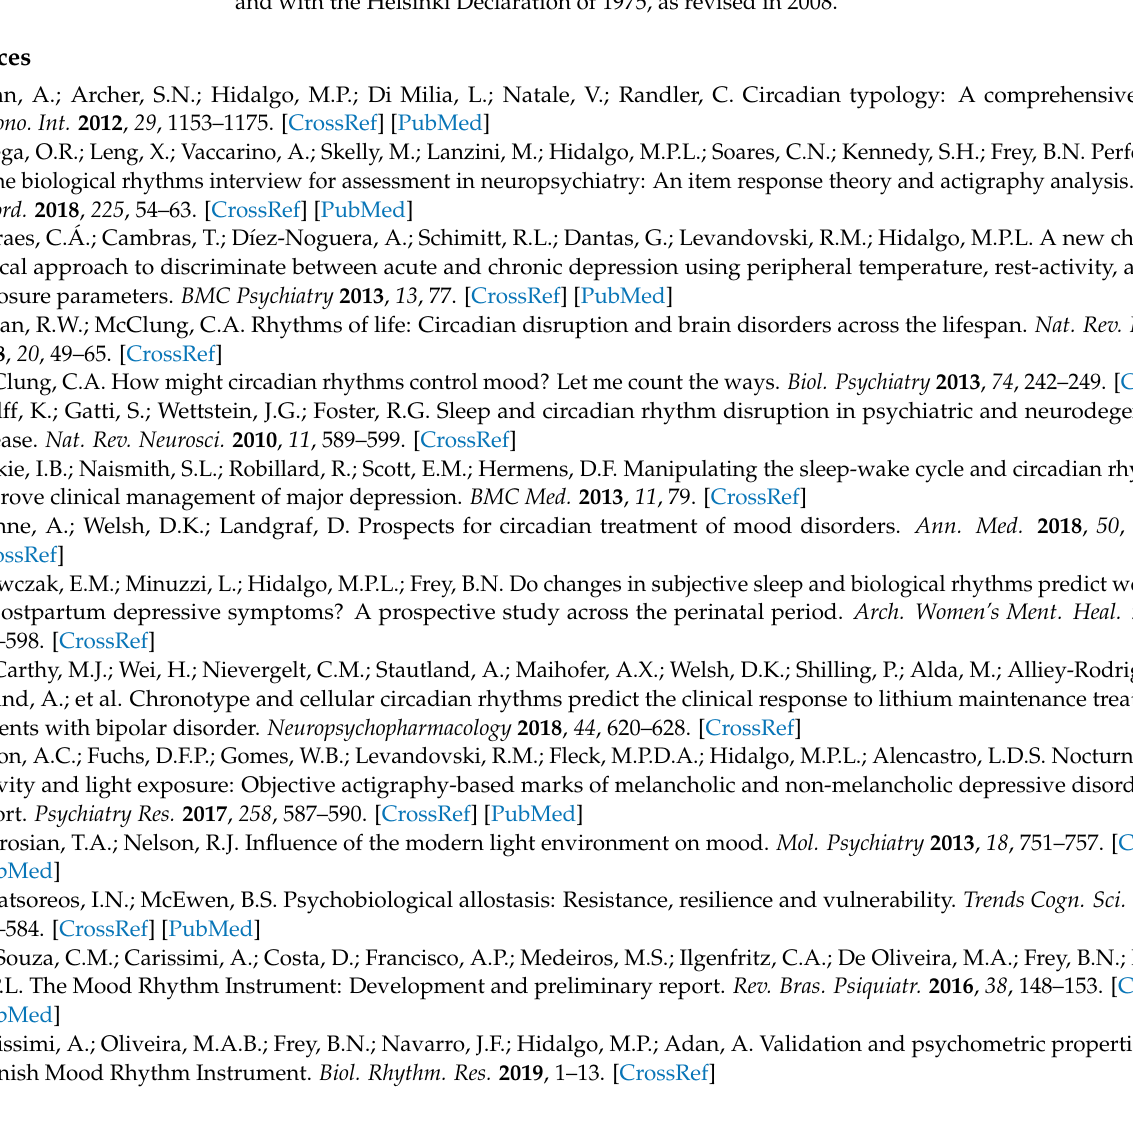
matrix. Table S2: Factor analysis (four factors). Table S3: Factor analysis (five factors). Table S4: Bivariate and regularized regressions correlations of the MRhI-r